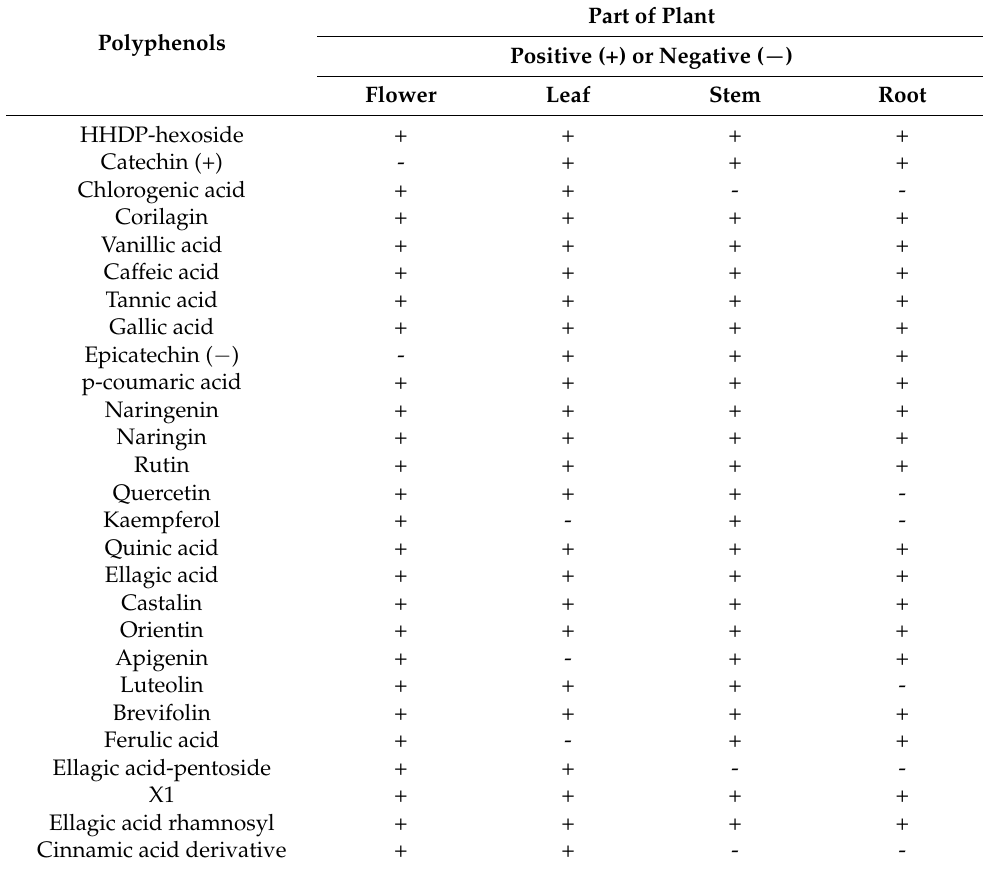
Table 3. Polyphenols present in different N. alba